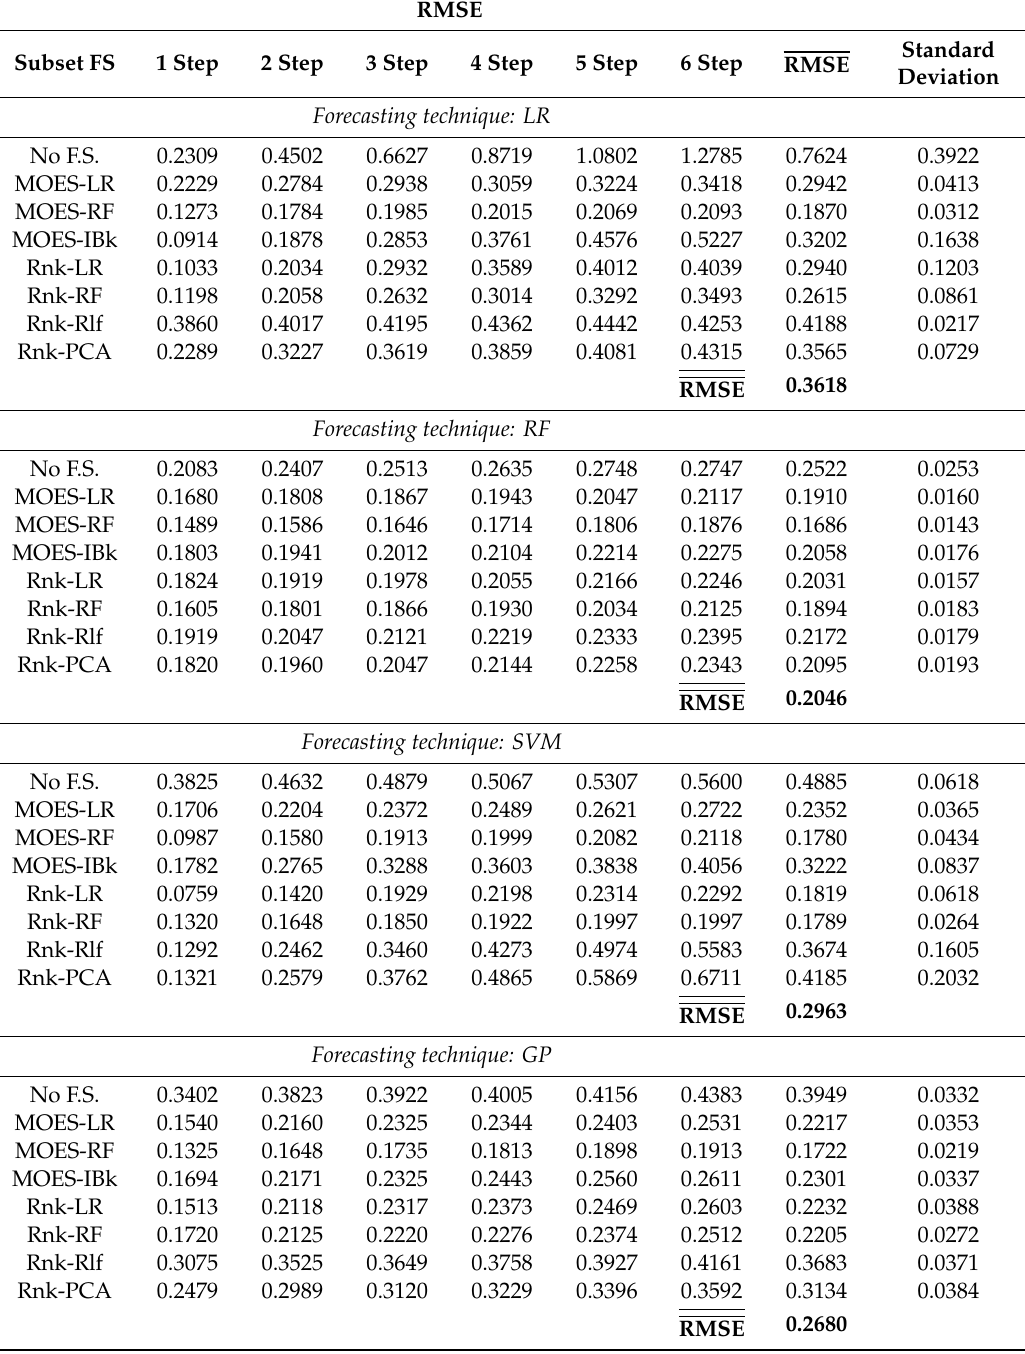
Table 5. RMSE to 6-step GBV complaints forecasting in